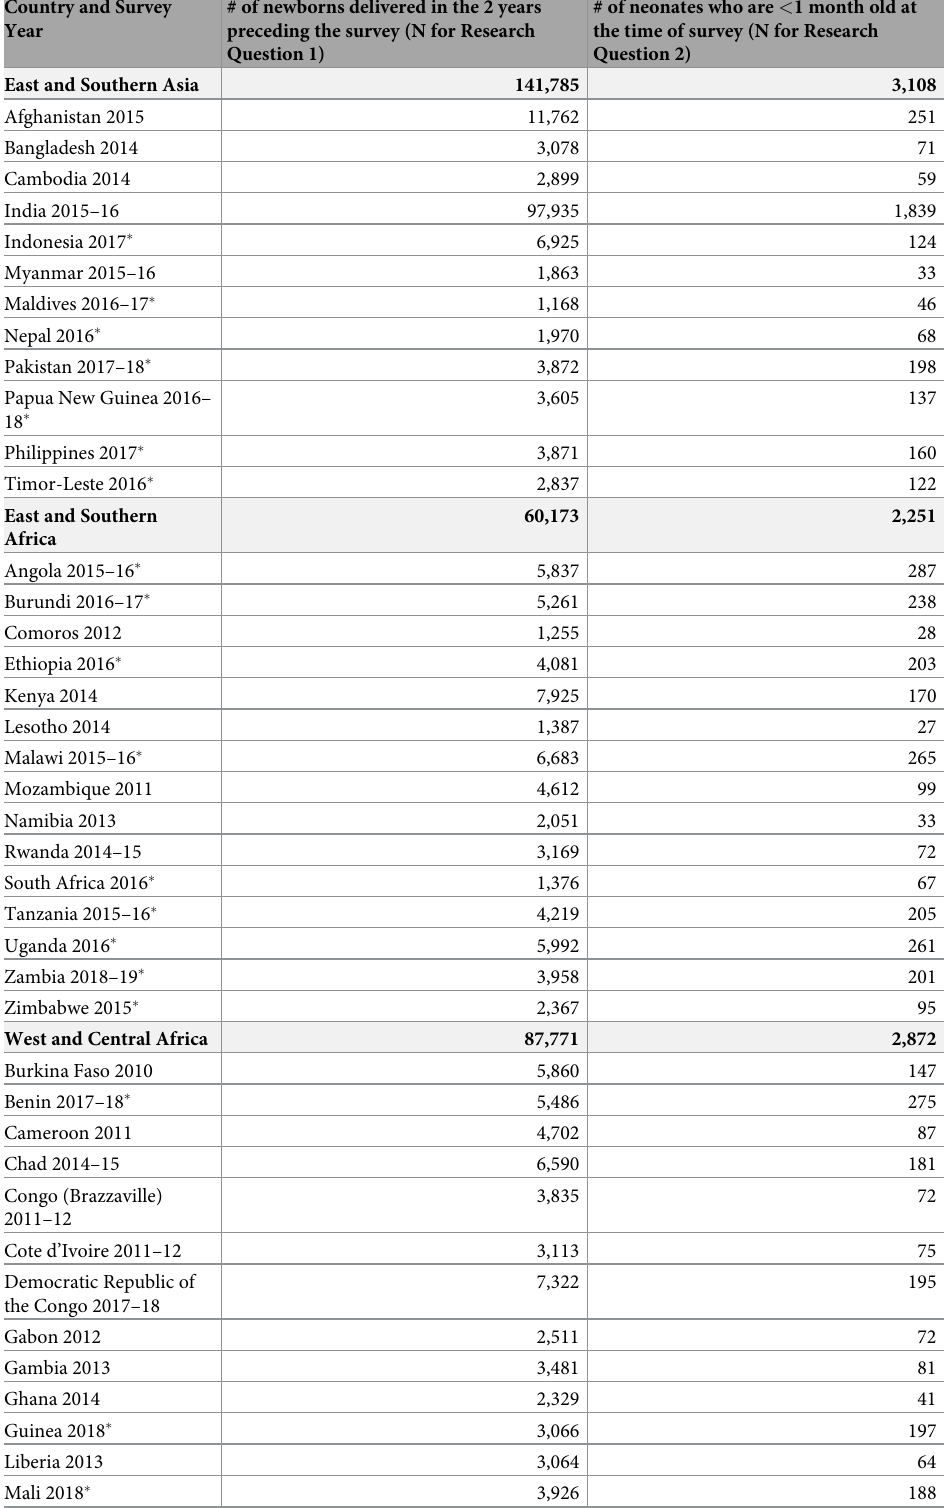
Table 1. Countries, survey years, and sample sizes included in analysis. Country and Survey